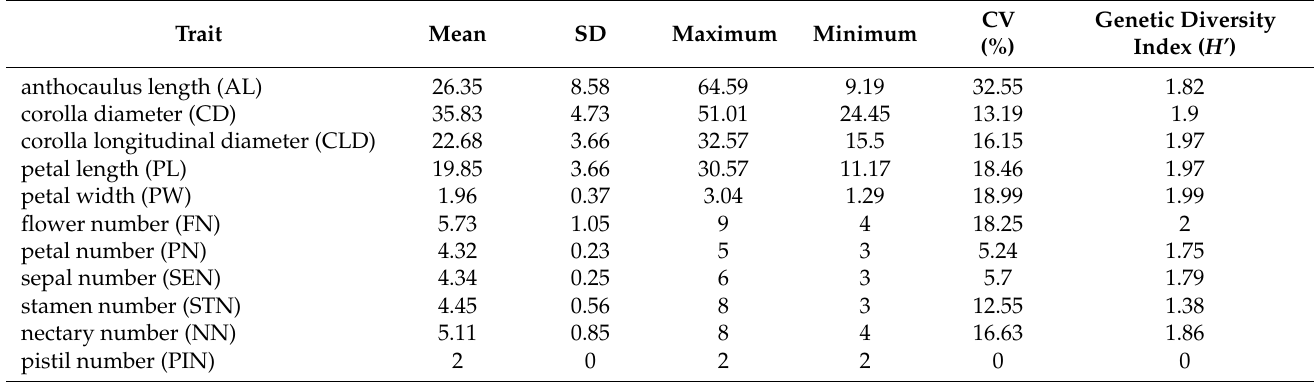
Table 2. Genetic diversity analysis of quantitative characters in flower organs of L. chinense var. rubrum .